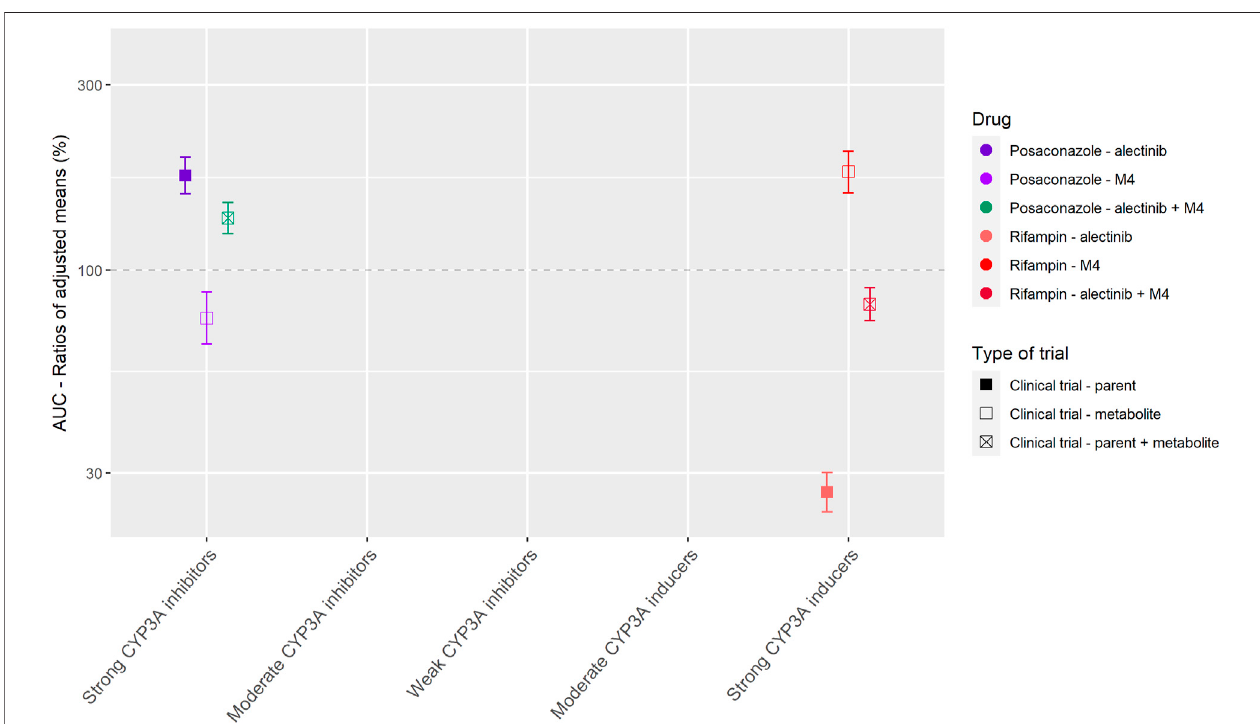
FIGURE 4 | Overview of the results from DDI studies of alectinib combined with CYP3A inhibitors and inducers. The coloured symbols represent the increase or decreaseinAUCcausedbytheinteractingdrug,expressedasadjustedmean ± 90%con fi denceinterval(ifavailable).ThedashedlinerepresentsthebaselineAUC(Food and Drug Administration, 2015a; Morcos et al.,